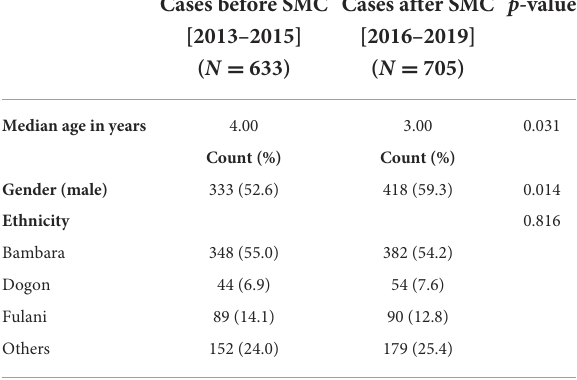
TABLE 1B Baseline characteristics of National Hospital of Mali severe malaria